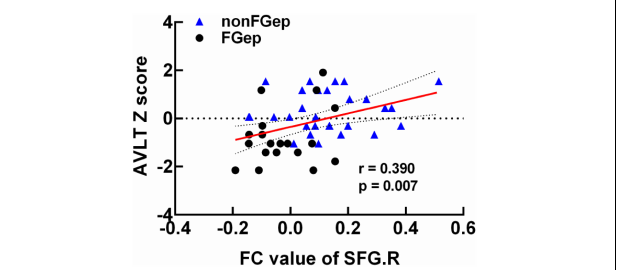
FIGURE 4 | Clinical behavioral significance of brain regions with differential FC between non-FGep and FGep subjects. non-FGep, frontal glioma without epilepsy; FGep, frontal glioma with epilepsy; SFG, superior frontal gyrus; FC, functional connectivity; AVLT, Auditory Verbal Learning Test- 20-min delayed recall.